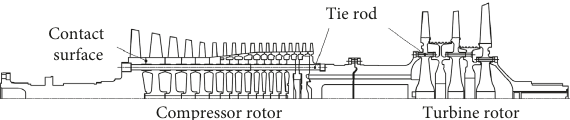
Figure 1: Typical structure of the rod-fastened